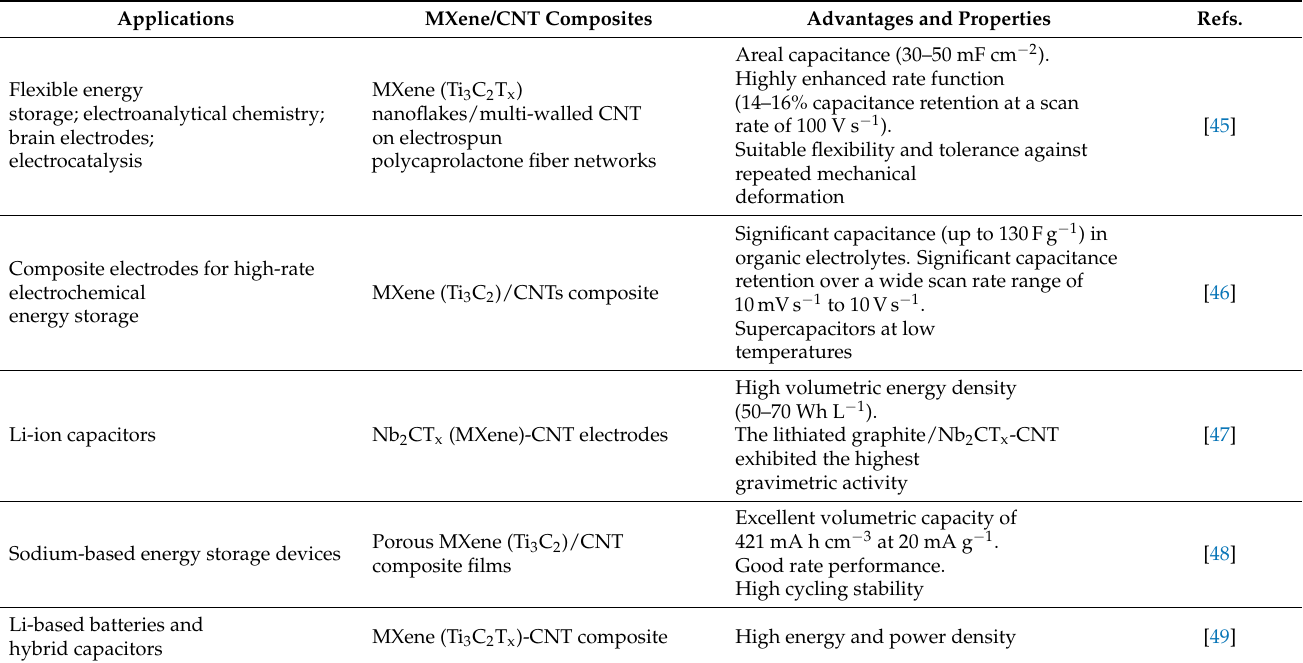
Table 1. Some selected examples of MXene/CNT composites with versatile